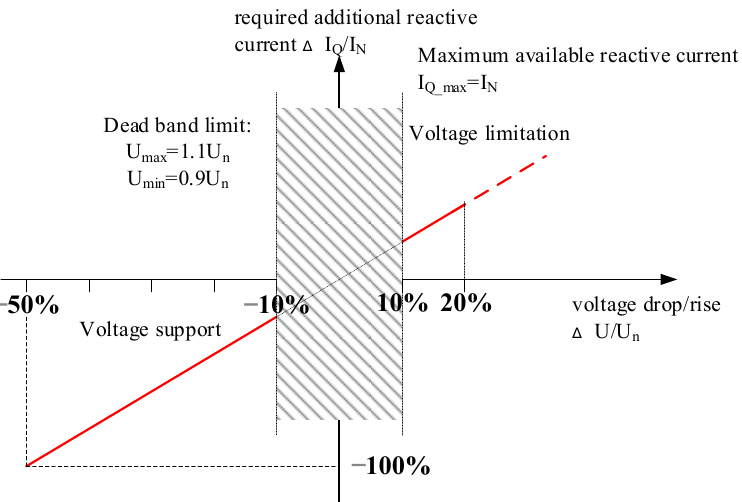
Figure 2. Requirements of reactive current compensation for WTGs by E.ON. (U denotes the system voltage, U N denotes the nominal voltage of the system; I Q denotes the reactive current; I N denotes the nominal current of the LVRTC in this study).